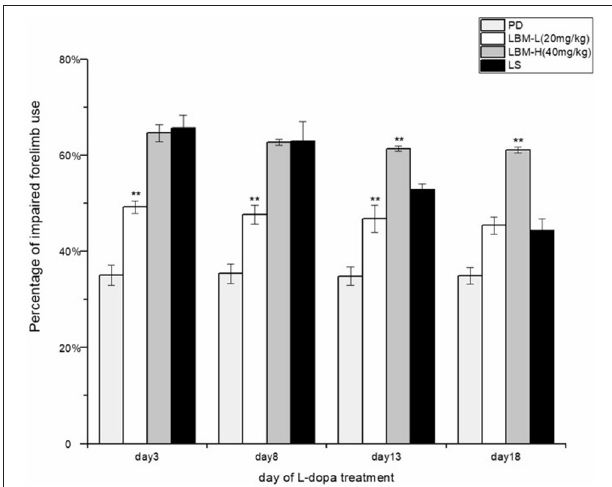
FIGURE 2 | Motor improvement of 6-OHDA lesioned rat models of PD treated with LBM-L (20 mg/kg) ( n = 8), LBM-H (40 mg/kg) ( n = 8), LS ( n = 8), or